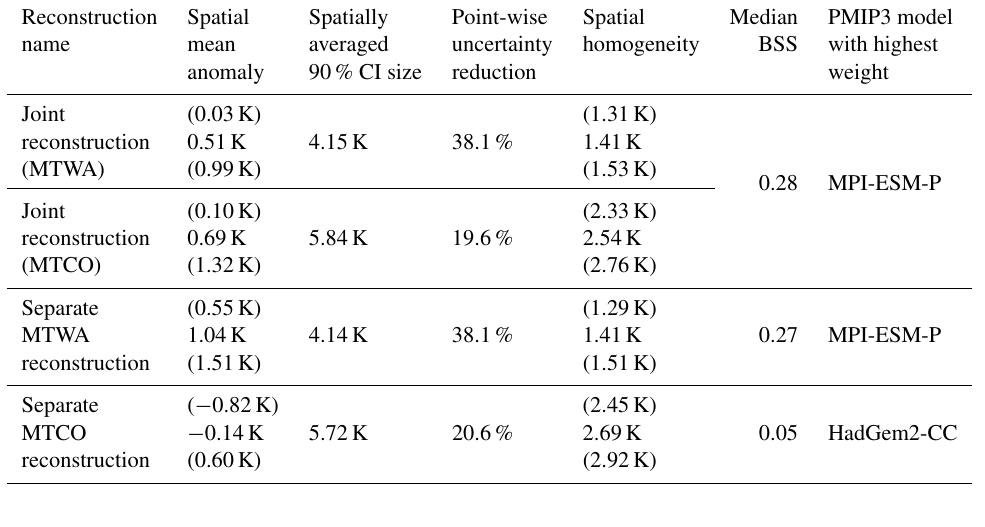
Table 3. Summary measures for the joint MTWA and MTCO reconstructions (rows 1 and 2) and the separated reconstructions of MTWA (row 3) and MTCO (row 4). Numbers in brackets are minima and maxima of the corresponding 90% CIs.